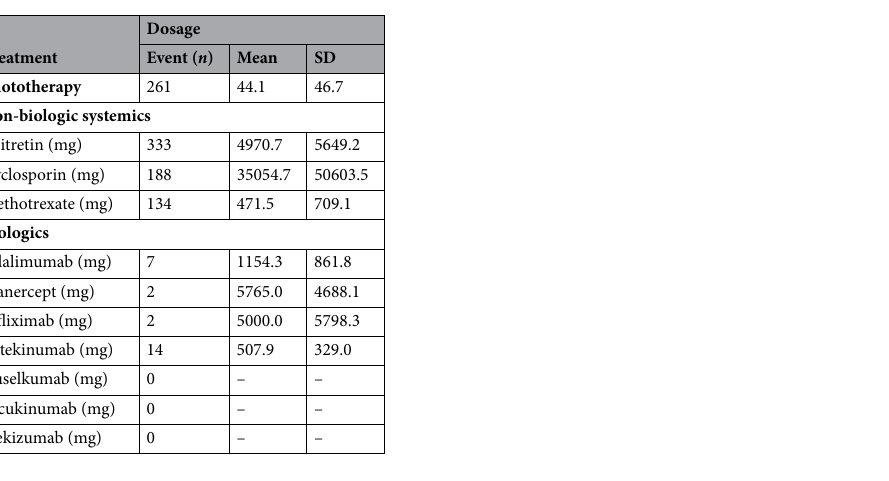
Table 3. Cumulative dosage of each anti-psoriatic treatment between the initiation date of each treatment and malignancy without NMSC. NMSC, nonmelanoma skin cancer; SD, standard deviation.